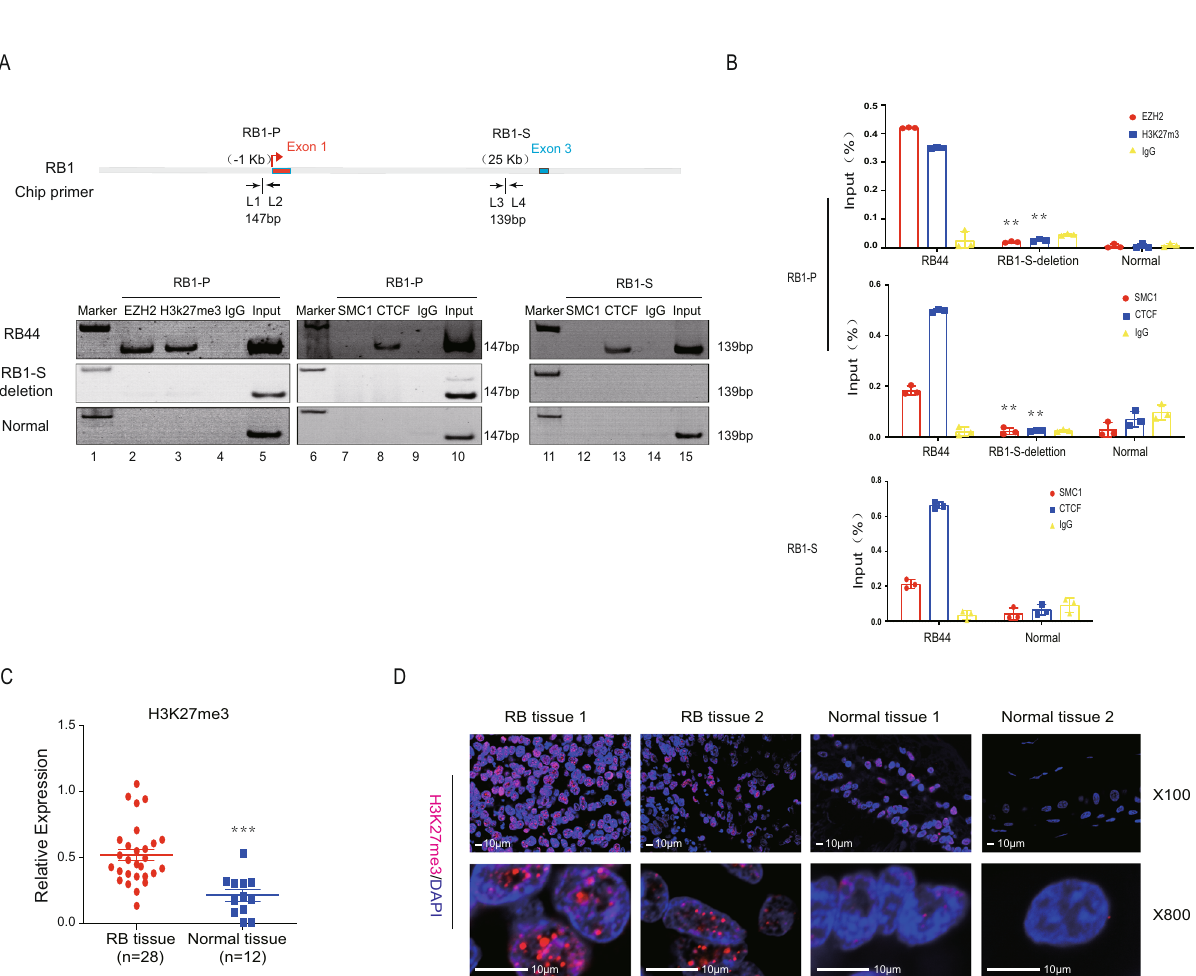
Fig. 2 Interruption of the chromosomal looping suppresses tumorigenesis. A Schematic of the RB1 suppressor fragment deletion by CRISPR-Cas9. B , C PCR and sequencing of the deletion of the 1.4-kb suppressor region from the genome by CRISPR-Cas9. WT, wild-type RB44 cells; RB1-S -deletion, 1.4- kb suppressor region deleted RB44 cells. E7F and E7R primers were used. D PCR was performed to test the RB1-P-S loop after RB1-S deletion. Primer pairs E5/E7, E5/E7F, and E5/E7R were used, respectively. E The Western blot analysis showed the expression of RB1 at protein level after RB1-S deletion. F An in vitro cell proliferation assay carried out by a cell counting kit showed the proliferation ability in RB1-S deletion RB44 cells and wild-type RB44 cells. ** P < 0.01. G A soft agar tumor formation assay was performed to determine the colony formation ability of RB1-S -deleted RB44 cells and wild-type RB44 cells. H Top: General photograph of orthotopic xenograft at 49 days after implantation by the injection of RB44 cells into the vitreous with or without RB1-S deletion; Bottom: representative images of H&E staining for the evaluation of tumor formation. n = 5. Scale bars: 1 mm. I The suppressive effects of RB1-S deletion on tumor weight in a subcutaneous xenograft model. * P < 0.05, ** P < 0.01. J PCR was performed to determine the RB1-P-S loop in the RB1-S deleted xenograft tissues. ** P < 0.01.